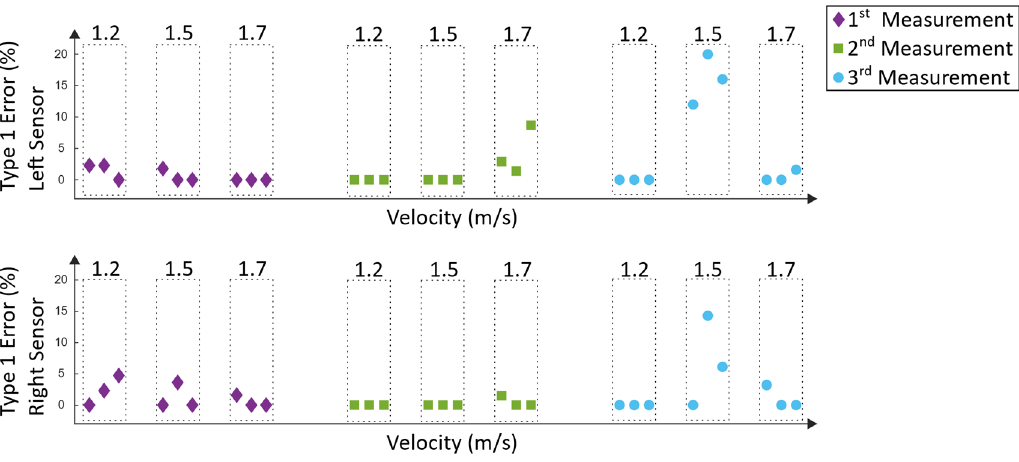
Figure 25. Type-1 errors of the Lyra measurements .